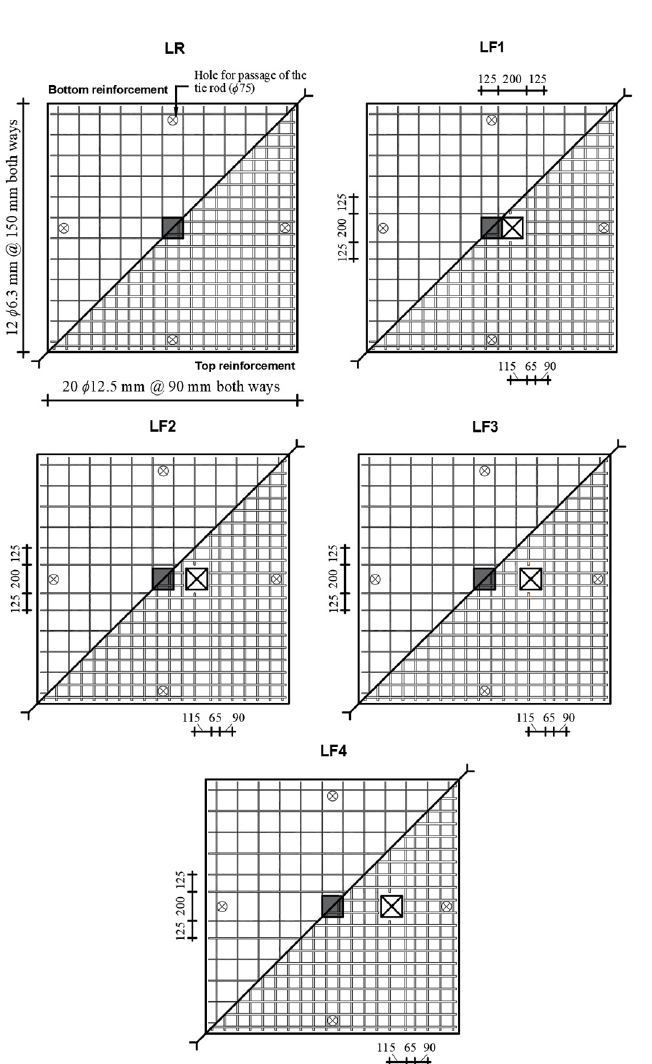
Figure 5. Slabs flexural reinforcements (units in